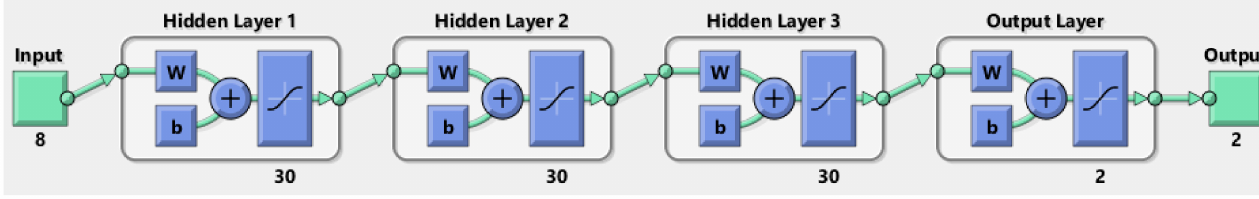
Figure 6. Network 1 configuration.